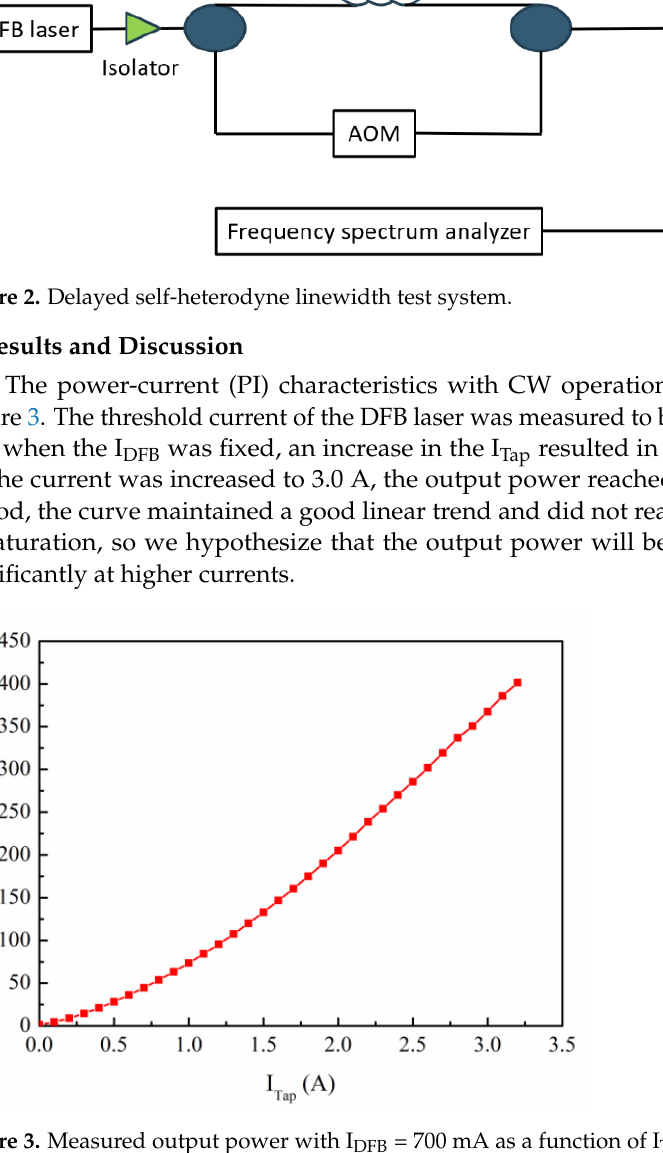
Figure 3. Measured output power with I DFB = 700 mA as a function of I Tap .